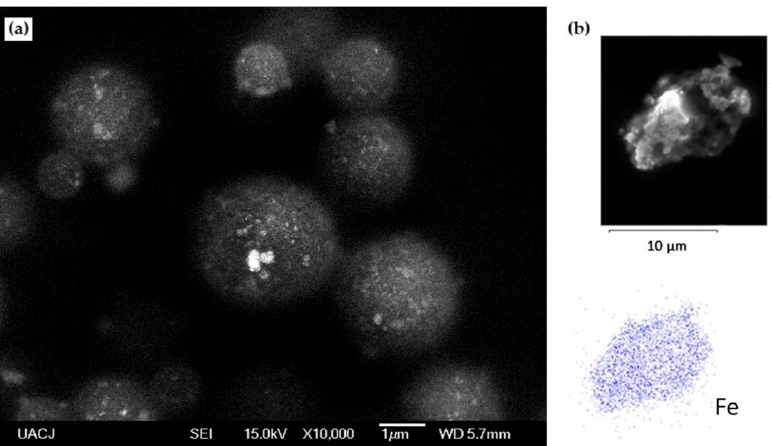
Figure 5. ( a ) SEM images of M-CS/Tween 80 microspheres at × 10,000; ( b ) EDS shows the distribution of Fe in the microsphere.